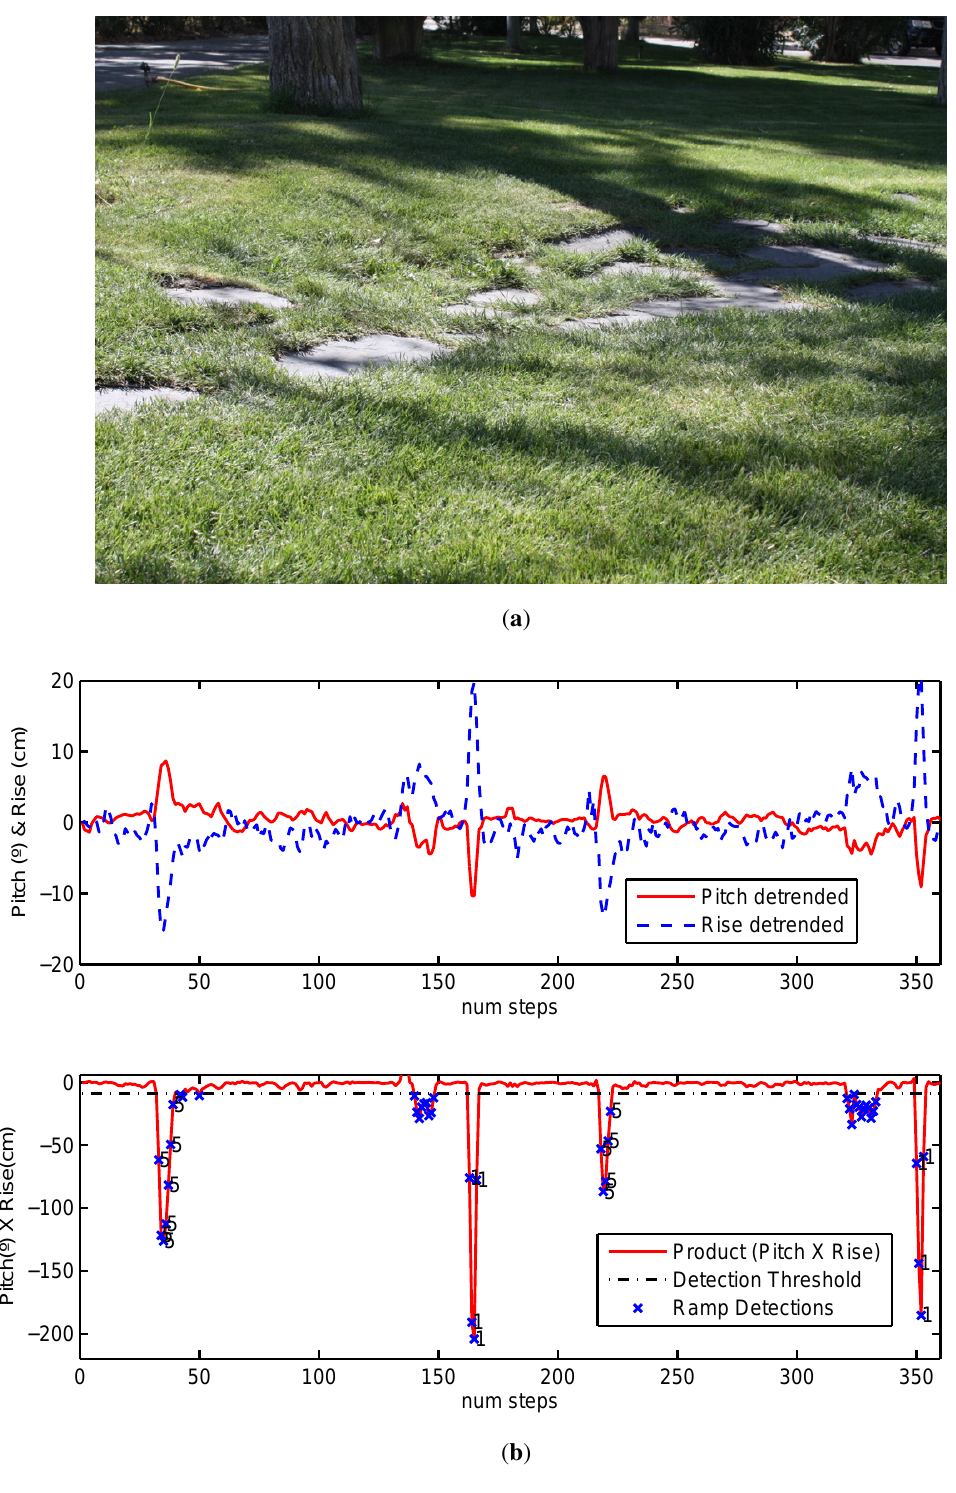
Figure 6. Ramp detection over irregular terrain: ( a ) Photograph of the uneven trail made of stones placed over the grass; ( b ) Ramp detections and associations, for 2 repetitions of a test visiting ramps 1 and 5, as well as the uneven trail; top graph: Estimated Pitch and Rise; bottom graph: Ramp detections (crosses) and the identification of ramps after the association (marked with the number of the associated